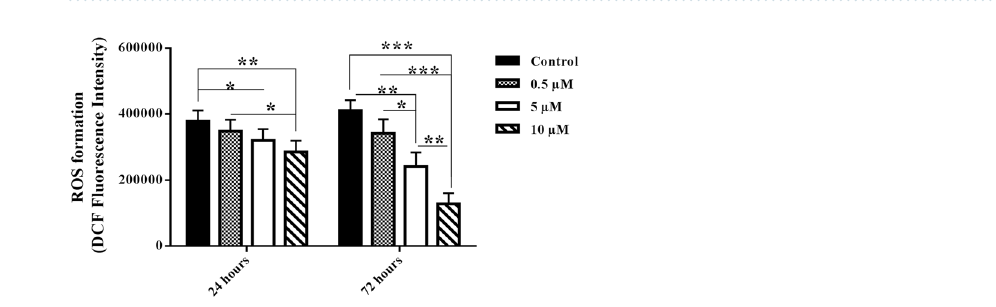
Figure 7. p53 protein expression ( A ) p53 protein expression by immunocytochemistry in the islets in different concentrations of nobiletin. Scale bar = 10 µ m. ( B ) The chart shows the H-score rate based on the percentage and intensity of the brown stained area islets in different groups (Yellow arrows show positive protein expression). The experiment was done in triplicate from four donors and data were analyzed by Kruskal-Wallis and Post-hoc tests. Results were represented as mean ± SD. * p < 0.05 and ** p < 0.01.